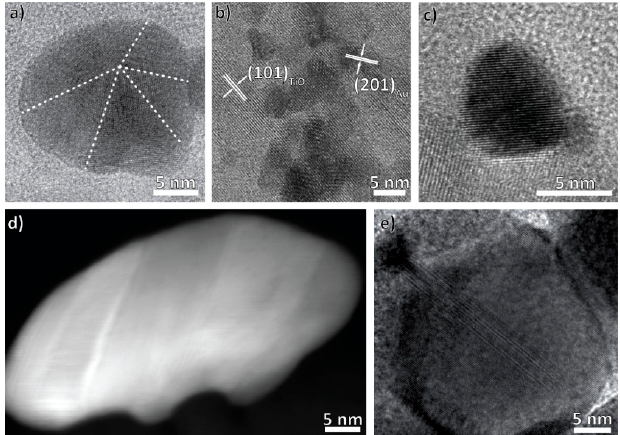
Figure 4. Representative images of different defect structures of the noble metal nanoparticles. In ( a ) and ( b ) high-resolution TEM (HRTEM) images of the photodeposited Au nanoparticles are shown: ( a ) is a five-fold twinned particle on top of the titania and ( b ) defect-free nanoparticles inside the titania. ( c – e ) show plasma-deposited nanoparticles: ( c ) is representative for small, defect free nanoparticles, ( d ) of those with stacking faults and ( e ) of those with grain boundaries.